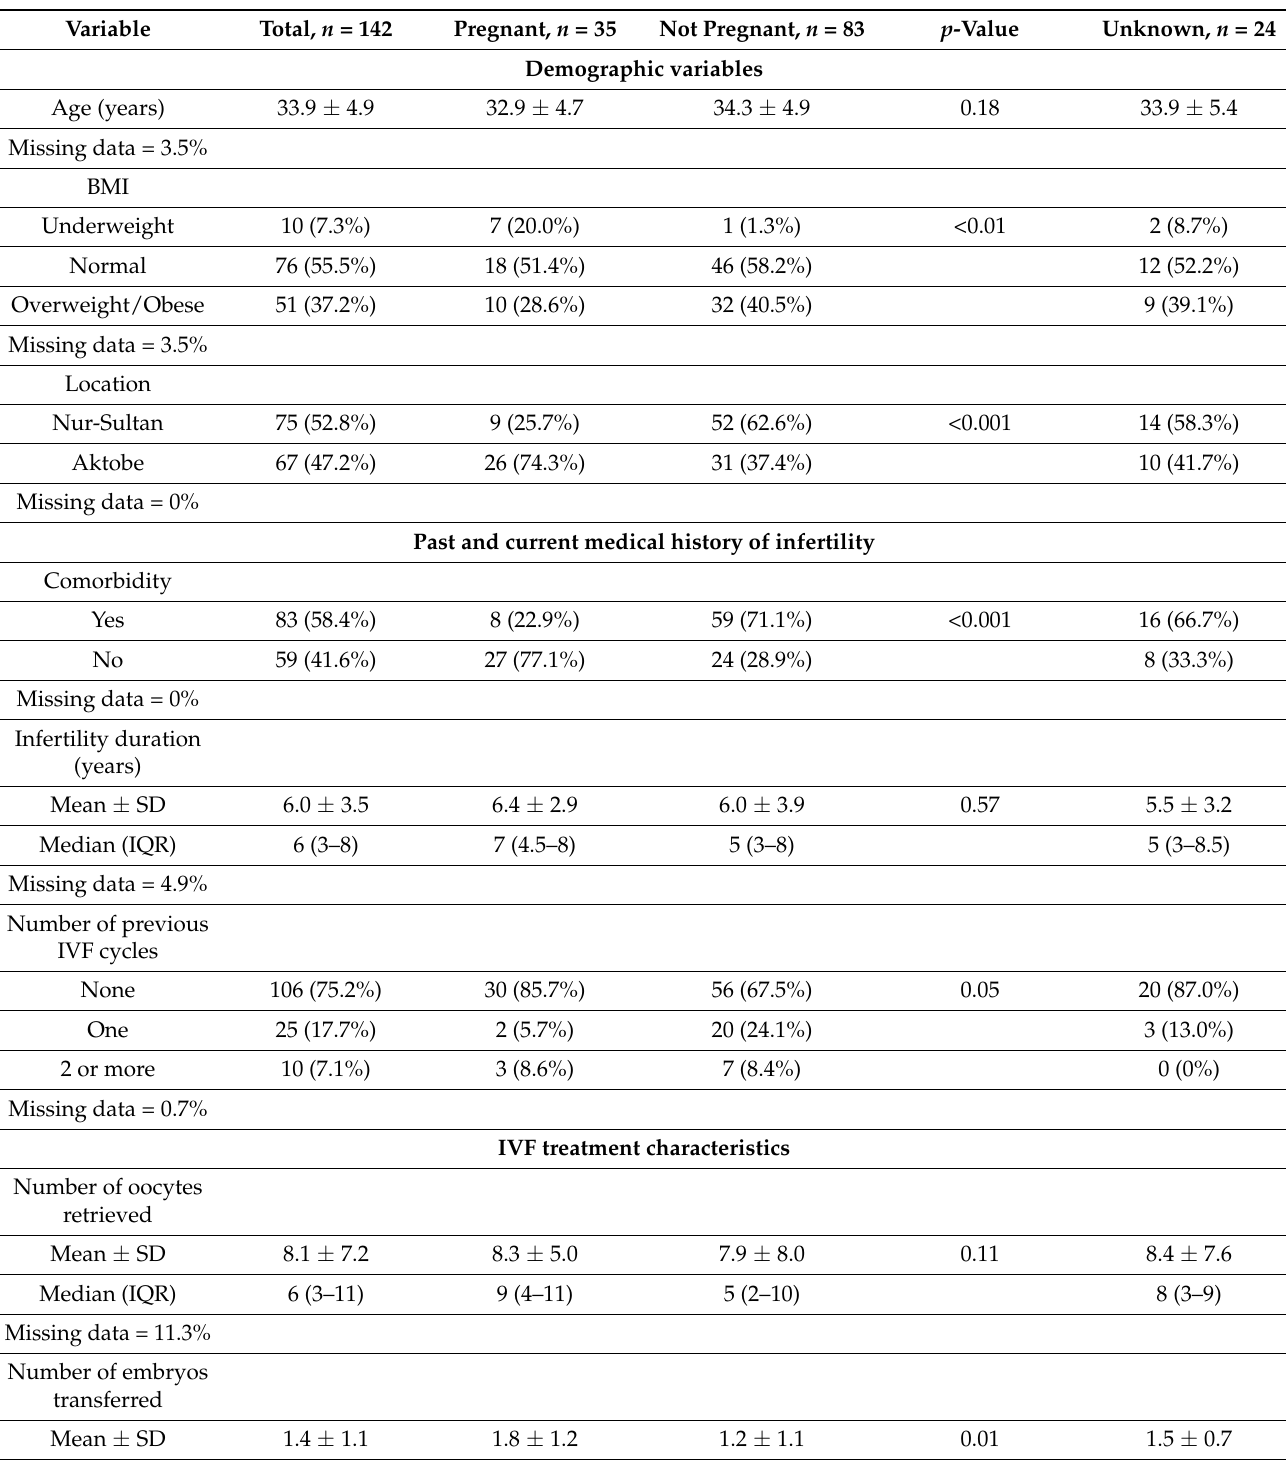
Table 1. Demographic, past clinical and in vitro fertilization (IVF) treatment characteristics of the study